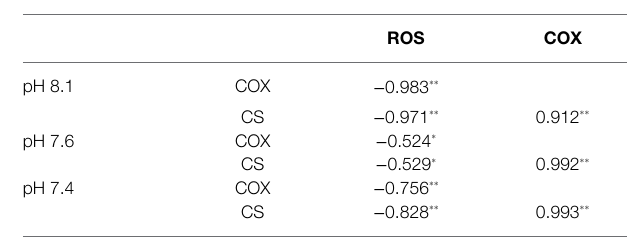
TABLE 5 | Pearson’s correlation coefficients between key enzyme activities and ROS levels in K. mikimotoi treated with seawater acidification.